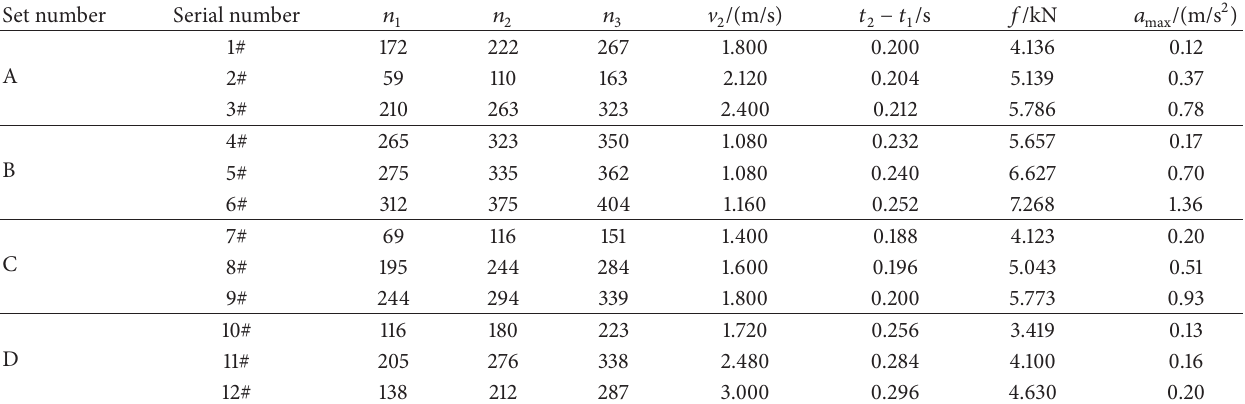
Table 2: Average force 𝑓 and peak acceleration 𝑎 max in all